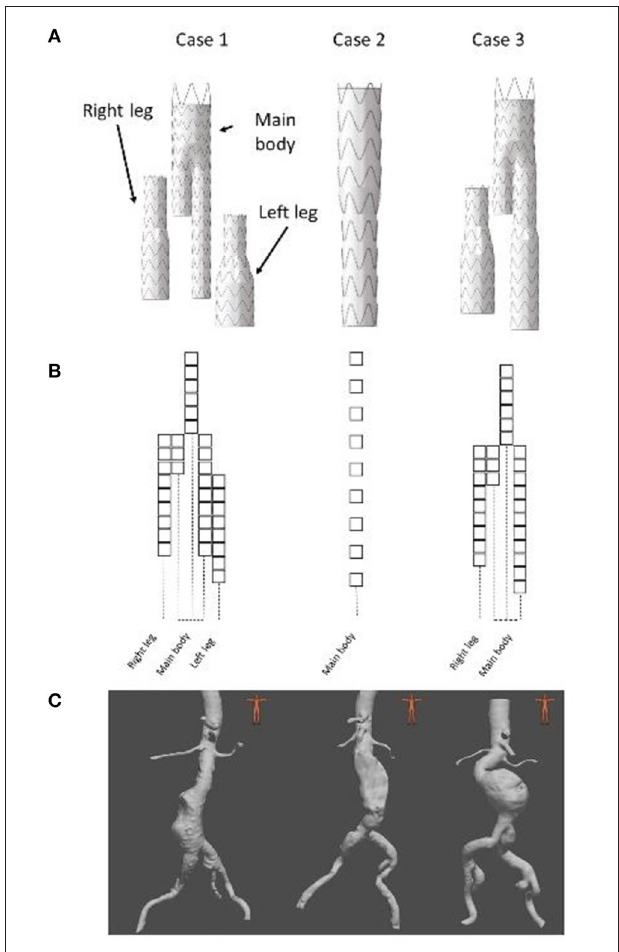
FIGURE 4 | Presentation of the 3 clinical cases, stent graft models used during the EVAR (A) , stent graft corresponding schemes (B) and preoperative geometries (C) .